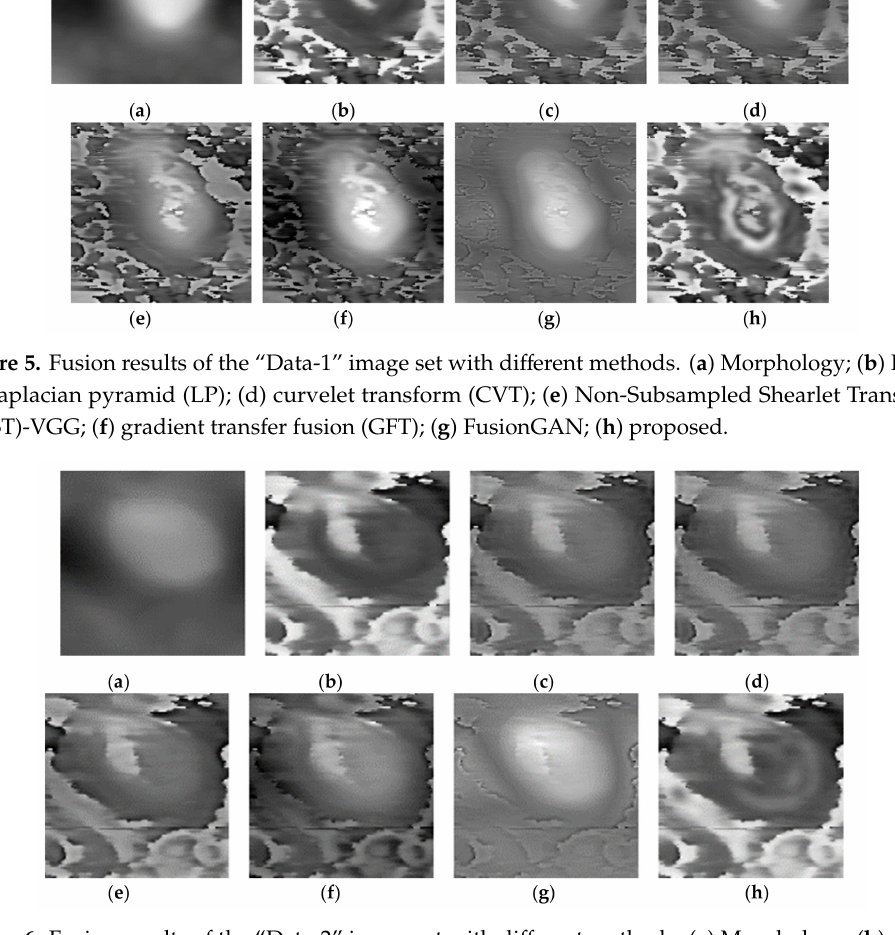
Figure 6. Fusion results of the “Data-2” image set with di ff erent methods. ( a ) Morphology; ( b ) phase; ( c ) LP; ( d ) CVT; (e) NSST-VGG; ( f ) GFT; ( g ) FusionGAN; ( h )